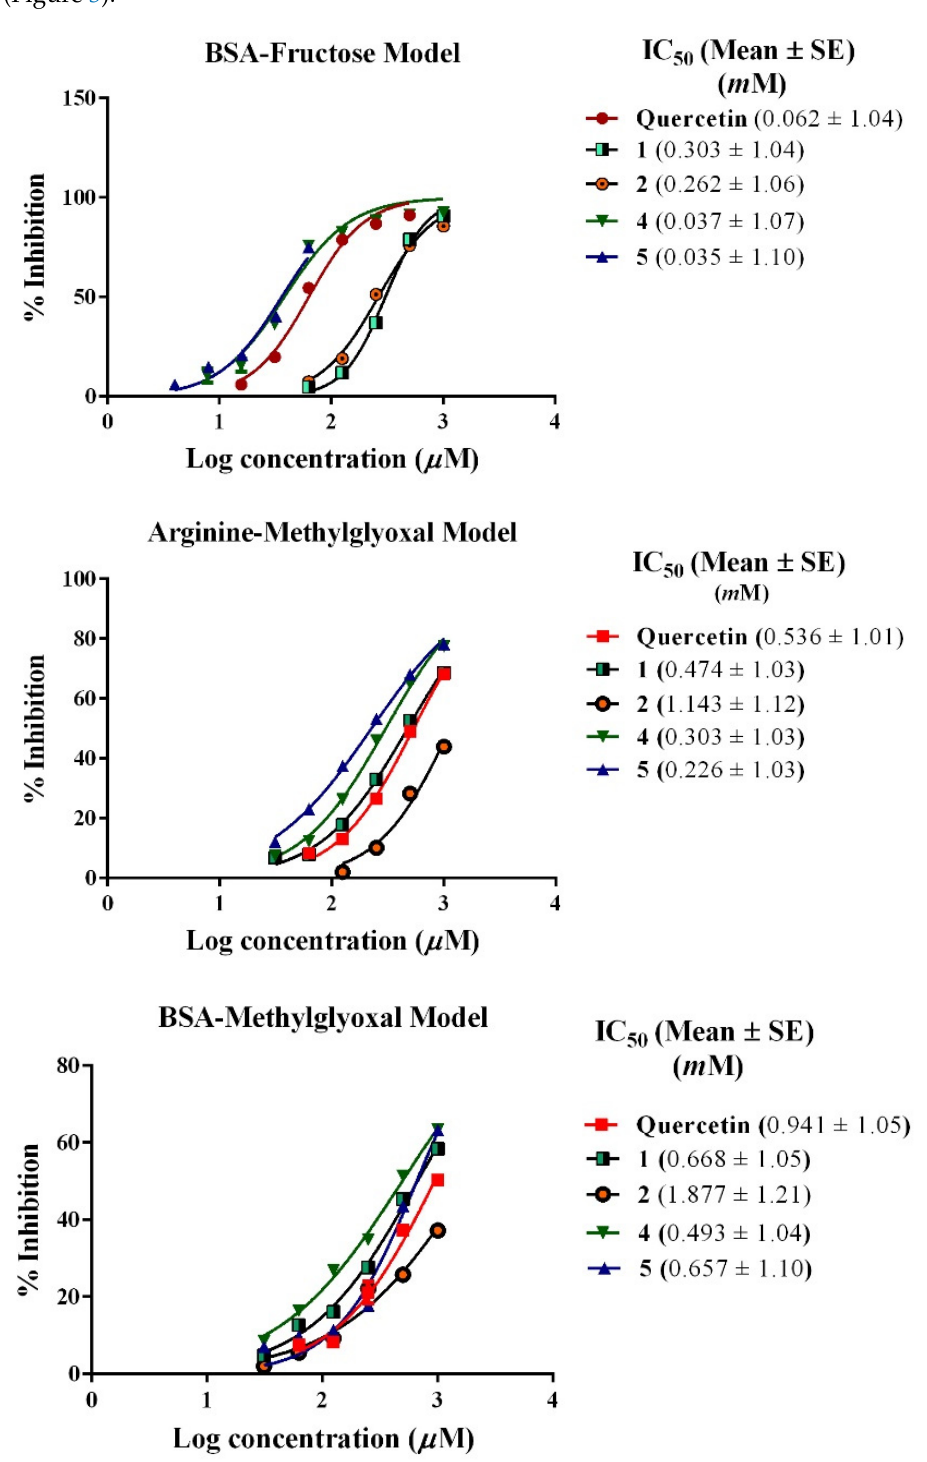
Figure 3. Inhibitory effect of the isolated compounds ( 1 – 5 ) from C. oblongifolia and quercetin on advanced glycation end products in the BSA-fructose, arginine-methylglyoxal model, and BSA- methylglyoxal